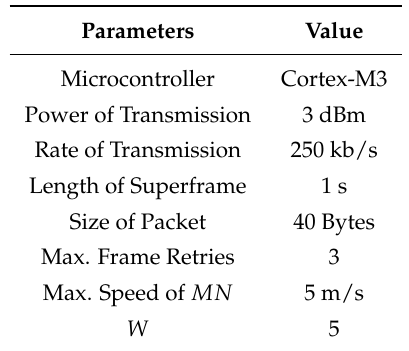
Table 1. Parameter